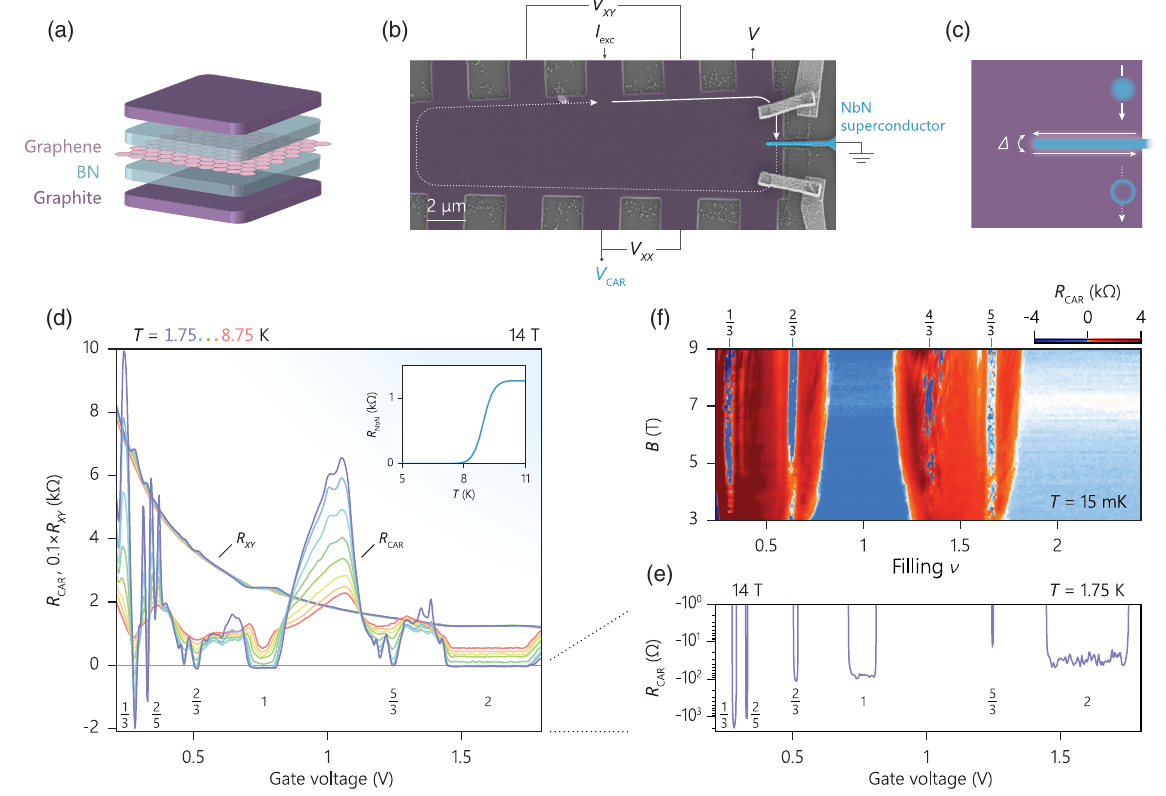
FIG. 1. The device and crossed Andreev reflection (CAR) in a FQH state. (a) Schematic of the heterostructure. Graphene is encapsulated with boron nitride dielectric and graphite. (b) Typical device including a NbN superconductor < 100 nm in width and ∼ 1 μ m in length (blue). The extended arms connect to normal leads (not shown) that are used to bias a current I , measure the voltages exc V and V , the potential of the edge mode propagating toward the superconductor V , and finally that of the edge mode propagating XX XY away V . The superconductor is grounded, remaining leads are floating. The solid and the dashed arrows depict, respectively, the CAR chiral electron and hole conduction in an out-of-plane magnetic field B . The metal electrodes on top graphite (gate) are bridges that connect the top gate to leads avoiding the edge of the heterostructure. (c) Illustration of the theory model. A narrow superconductor induces a pairing gap Δ between the counterpropagating fractional quantum Hall edges along both sides. Δ converts an incoming ¼ V ¼ V =I =I electron to an outgoing hole by crossed Andreev reflection. (d) R and R as a function of gate voltage XY XY CAR CAR exc exc < 0 at fractional quantum Hall plateaus indicates hole conductance measured at B ¼ 14 T for different temperatures T . An R CAR (CAR). Measured R for ν < 1 (high channel impedance) is slightly lower than the expected quantized values, with up to ∼ 10 % XY deviation for ν ¼ 1 = 3 , due to a resulting small low-pass frequency in this experimental setup. Similar signal magnitude reduction is expected for R for ν < 1 . This effect does not result in a spurious negative contribution that can increase the negative CAR reading. CAR Inset of (d) shows the resistance of a narrow NbN for varying T which superconducts below 8 K at 14 T. (e) R at 1.75 K from (d). CAR < 0 ) is observed at 3 T for ν ¼ 2 = 3 (f) R as a function of filling ν and B measured at 15 mK. CAR ( R CAR CAR